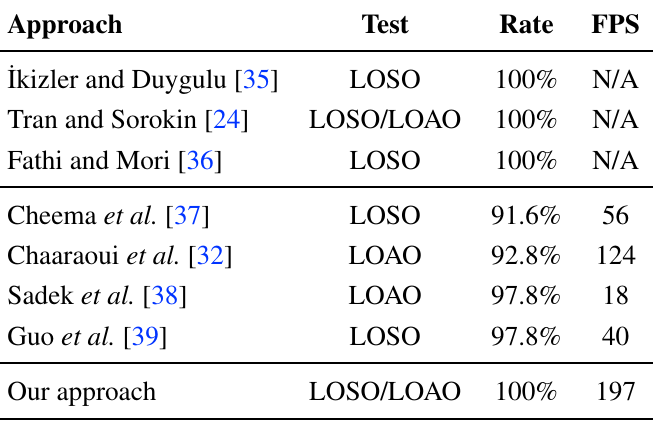
Table 3. Comparison of recognition rates and speeds (in frames per second (FPS)) obtained on the Weizmann dataset with other state-of-the-art approaches. LOSO, leave-one-sequence-